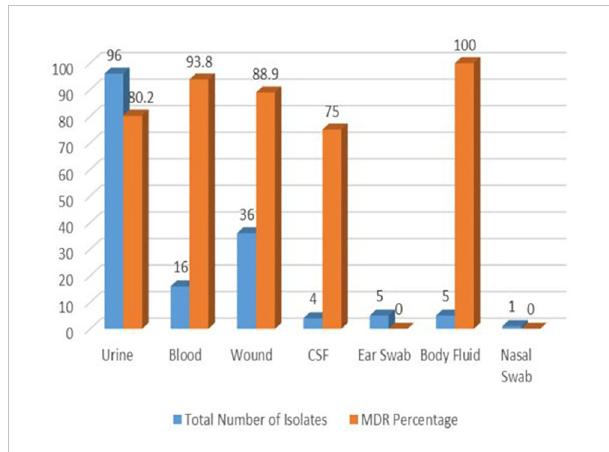
FIGURE 1 Distribution of GNB in Different Clinical Specimens.